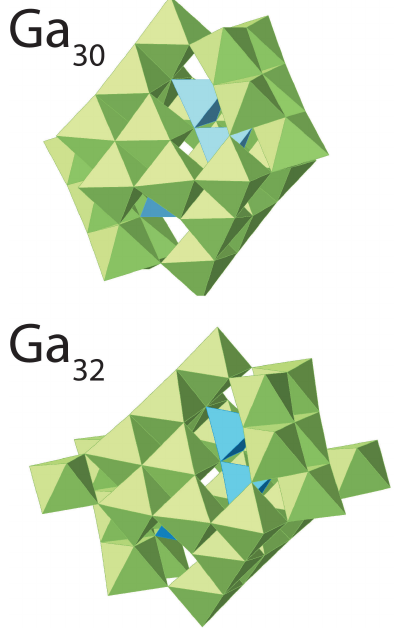
Figure 1. The topology of the Ga 30 cluster shown in polyhedral representation and in a similar orientation as that of the Ga 32 discovered by Gerasko et al. [12]. The central Ga(O) 4 sites in tetrahedral coordination are colored blue and the Ga(O) 6 are green.